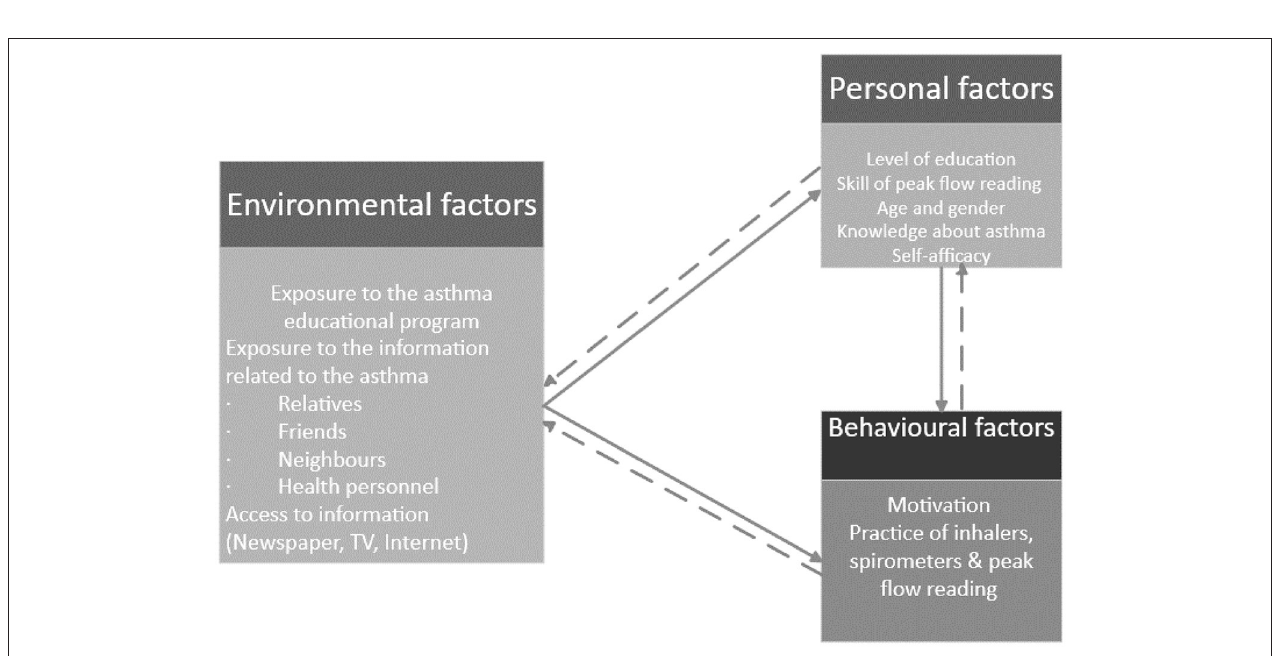
FIGURE 3 | Applies Bandura’s social cognitive theory in the context of an asthma education program (Developed by the